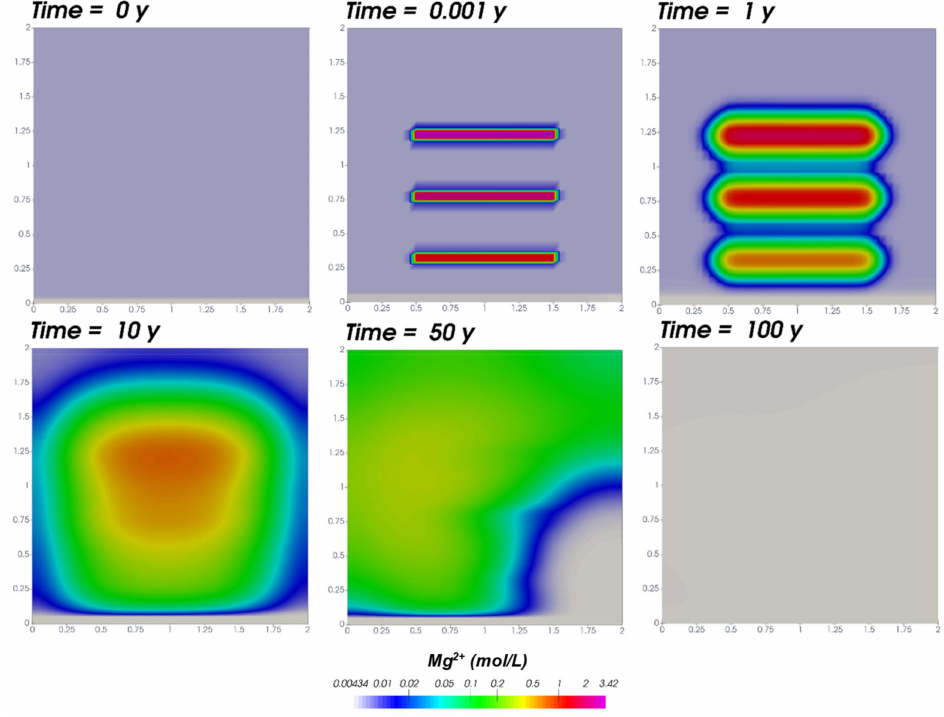
Figure 14. Spatial distribution of the concentration of dissolved Mg 2+ at selected times in the simulation of scenario 4 (a log scale is used to map data to